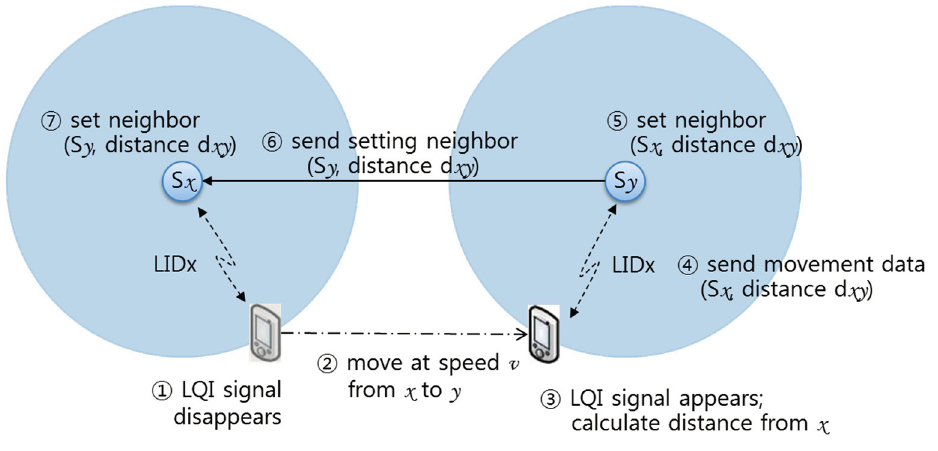
Figure 8. Automatic method to connect physical neighboring SLiM